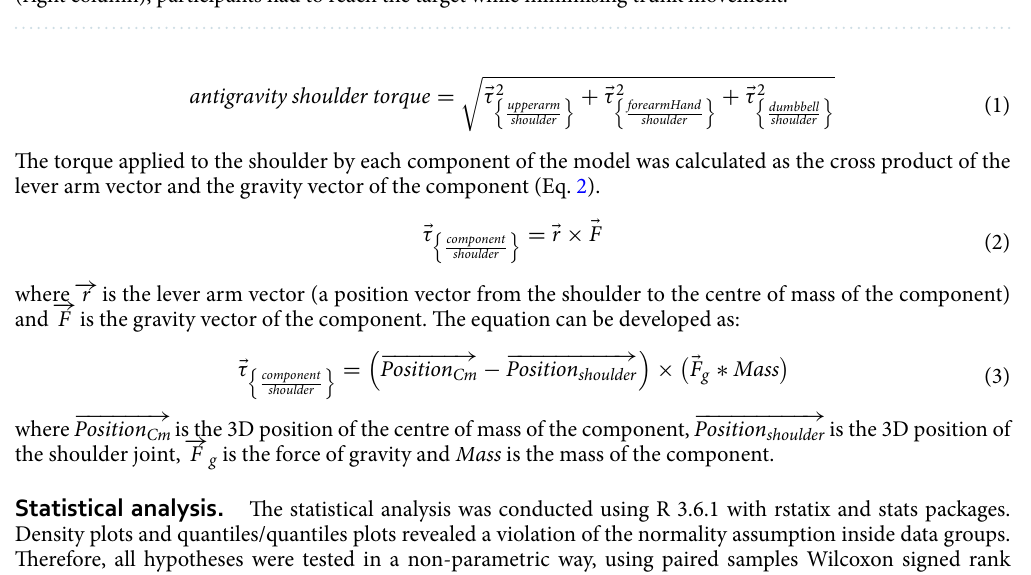
Figure 1. Schema of the four experimental conditions. In the loaded conditions (upper row), participants held a dumbbell which mass corresponded to 75% of their maximal voluntary shoulder force (MVF). In the unloaded conditions (lower row), participants had to reach the target without the dumbbell. In the spontaneous conditions (left column), participants had to reach the target in a natural way. In the trunk restraint conditions (right column), participants had to reach the target while minimising trunk